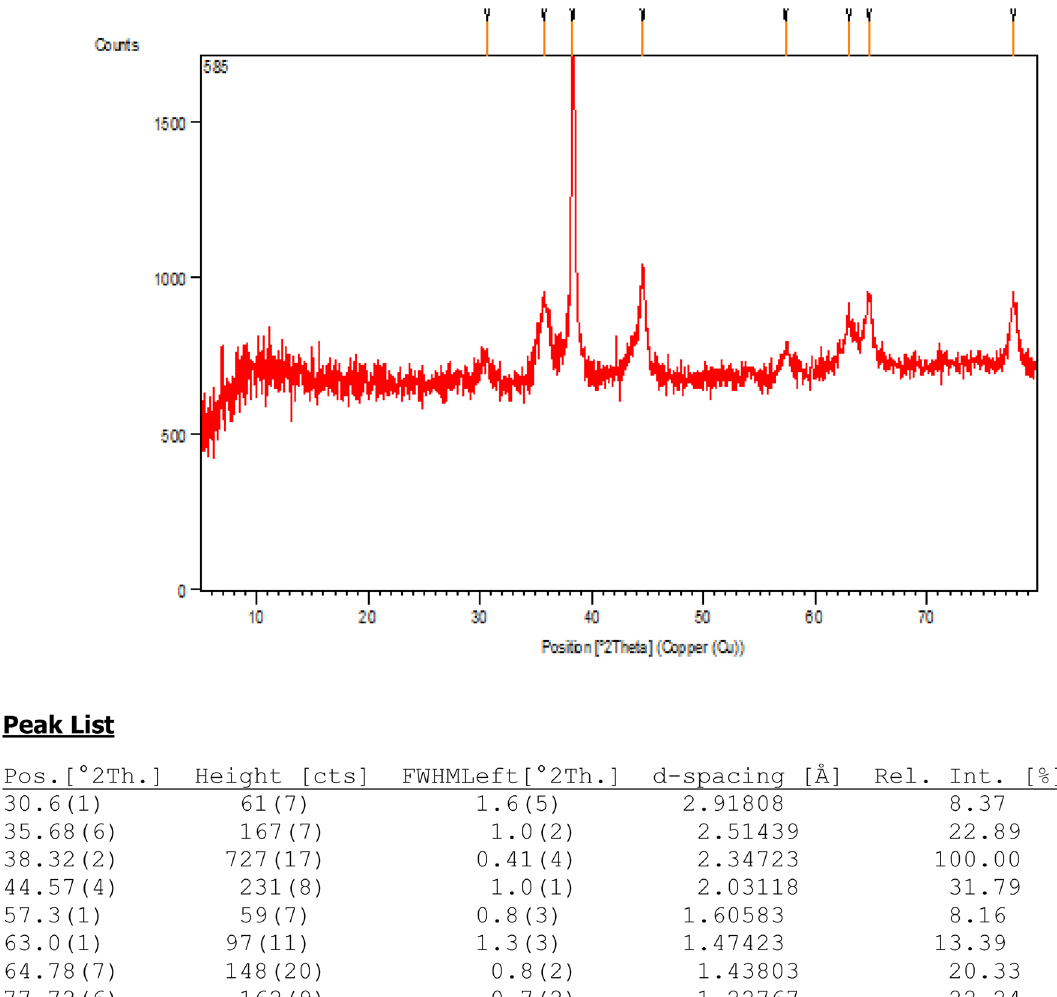
Figure 6. XRD pattern and the peak lists of GO/Fe 3 O 4 @PDA/Au